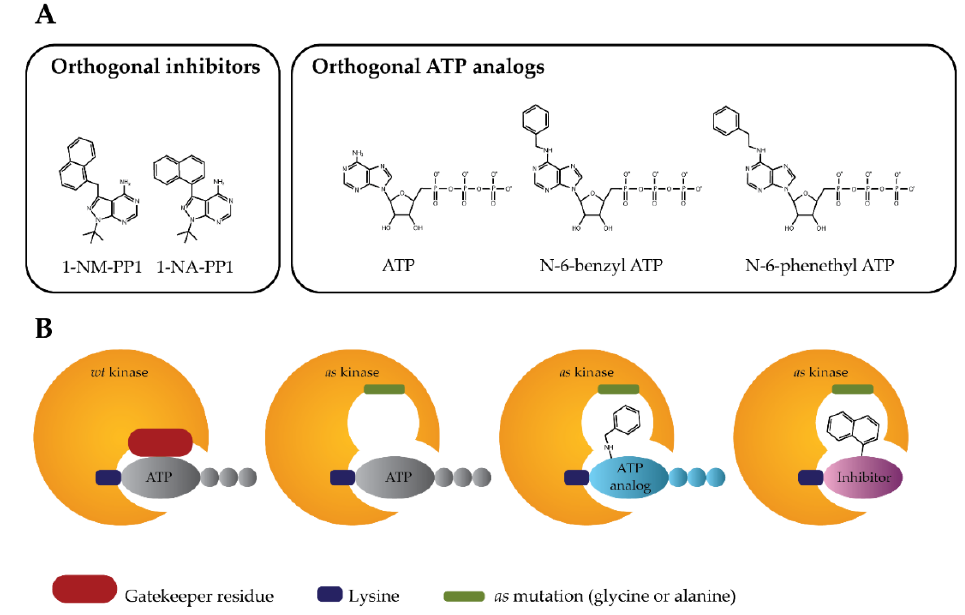
Figure 1. Analog-sensitive kinase technology. ( A ) Structures of orthogonal inhibitors or orthogonal ATP analogs designed to inhibit analog-sensitive ( as ) protein kinase mutants. ( B ) A schematic diagram of the analog-sensitive protein kinase technology illustrates the specific binding of bulky orthogonal ATP analog or orthogonal inhibitor to mutant as protein kinases. 1-NM-PP1: 4-Amino-1-tert-butyl-3-(1′-naphthylmethyl)pyrazolo[3,4-d]pyrimidine; 1-NA-PP1: 4-Amino-1-tert-butyl-3-(1′- naphthyl)pyrazolo[3,4-d]pyrimidine.